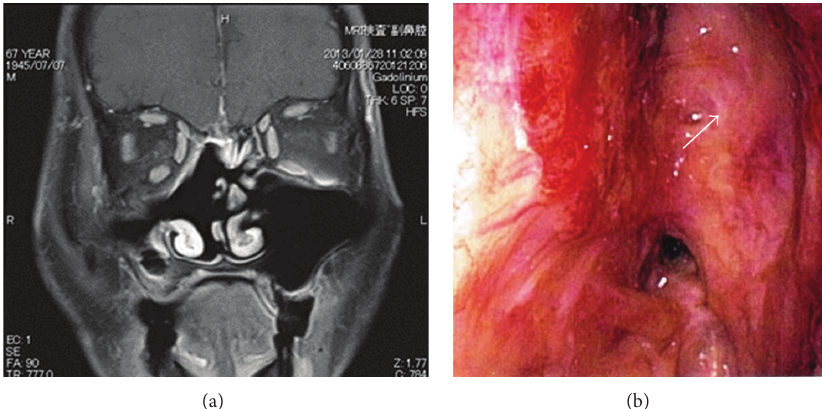
Figure 8: Postoperative MRI and local finding in case 2. (a) T1-weighted coronal image (gadolinium+) showing no recurring mass. (b) The white arrow shows the pedicled nasal septal flap in the right nasal cavity.